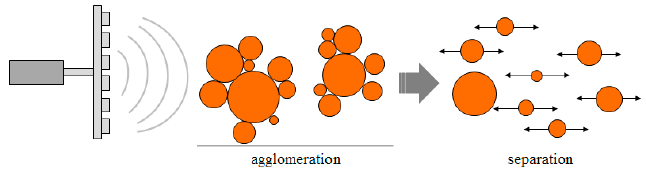
Figure 1. Schematic diagram of ultrasonic generator.